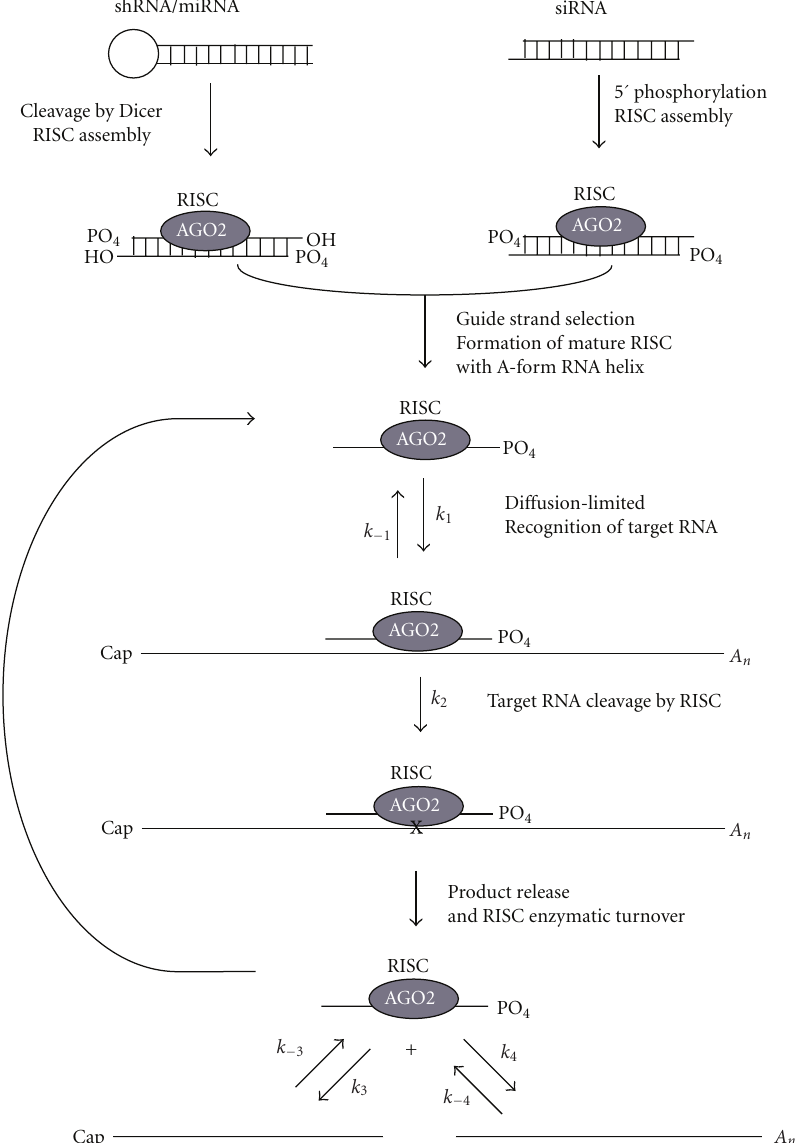
Figure 3: RNAi mechanism. An expressed RNA hairpin (shRNA) is cleaved first by Dicer III to a double-stranded RNA of 21 nt with 5 (cid:3) phosphorylated ends. A pri-miRNA is processed in the nucleus into a pre-miRNA by Drosha, leaves the nucleus, and is further processed by Dicer in the cytoplasm or as part of RISC. Or a transfected or transduced siRNA is phosphorylated at each 5 (cid:3) end. The short dsRNAs are incorporated into the RISC complex, and the antisense strand (guide strand) is selected on the basis of engineering weaker 5 (cid:3) energy than 3 (cid:3) energy. The passenger strand is displaced. The guide strand is organized into RISC as an A-form α -helix within Ago2, which is the RNA endonuclease of RISC. By di ff usion limitations, loaded RISC searches for a complimentary partner to its antisense element in the transcriptosome. Upon collision, kissing complex formation and full annealing, the target RNA is positioned for endonuclease cleavage by Ago2. After cleavage, it is thought that ATP hydrolysis occurs, which provides helicase energy to strip the products from the Ago2 cavity in order to prevent product inhibition on RNAi. Product release then frees the charged RISC to seek other target mRNAs for subsequent rounds of Michaelis-Menten